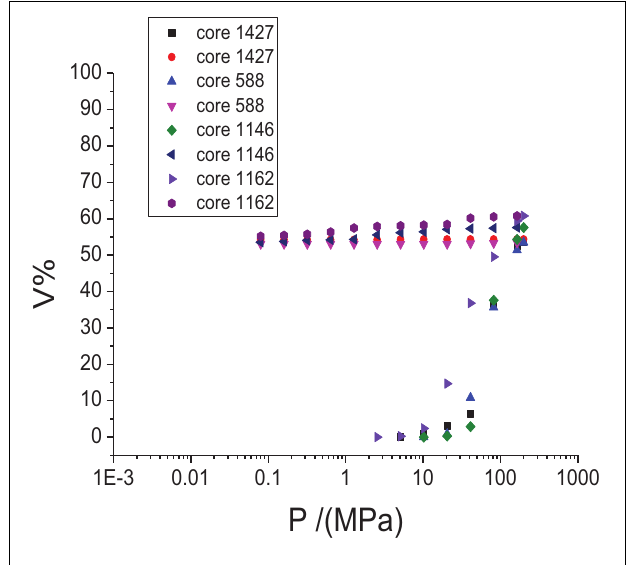
FIGURE 14 | Mercury injection